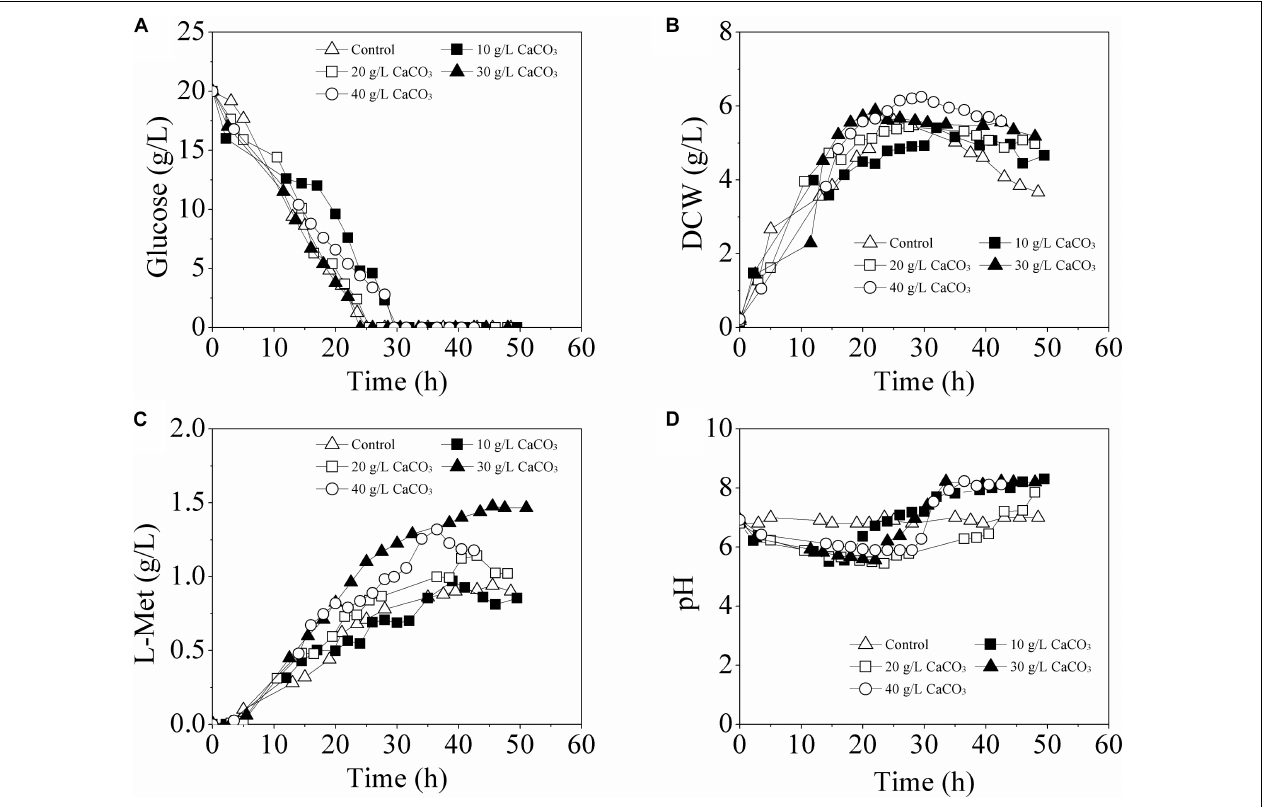
FIGURE 2 | Time course of fermentative production of L -Met with E. coli W3110-BL in 5-L fermentor supplemented with different amounts of CaCO 3 . (A) glucose consumption; (B) cell growth; (C) L -Met biosynthesis; (D) pH variation. All measurements were performed in triplicate. For clarity, the error bars were not displayed.